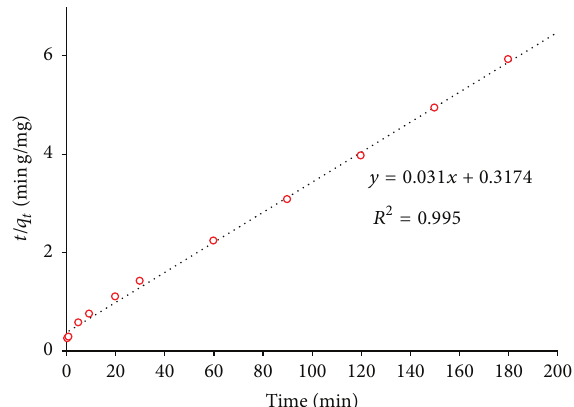
Figure 14: Pseudo-second-order plot for adsorption of copper ions onto CaHBSW.